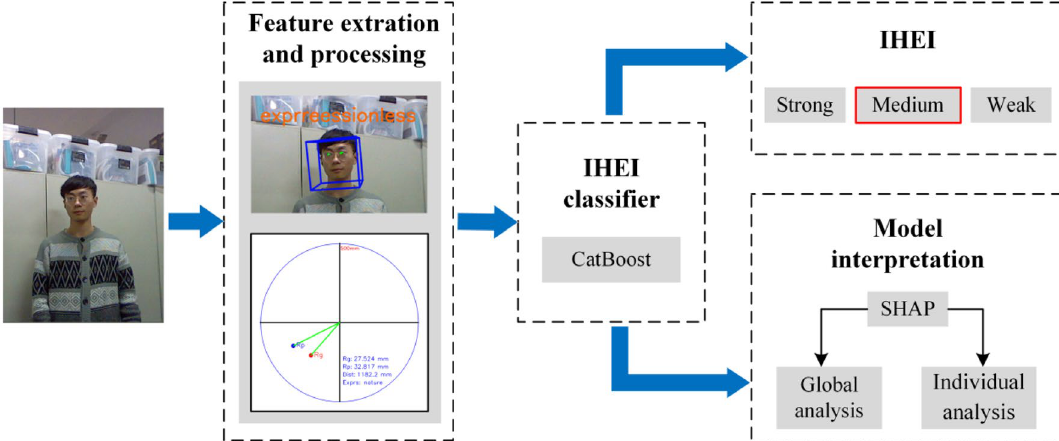
Figure 2. Flow chart of our